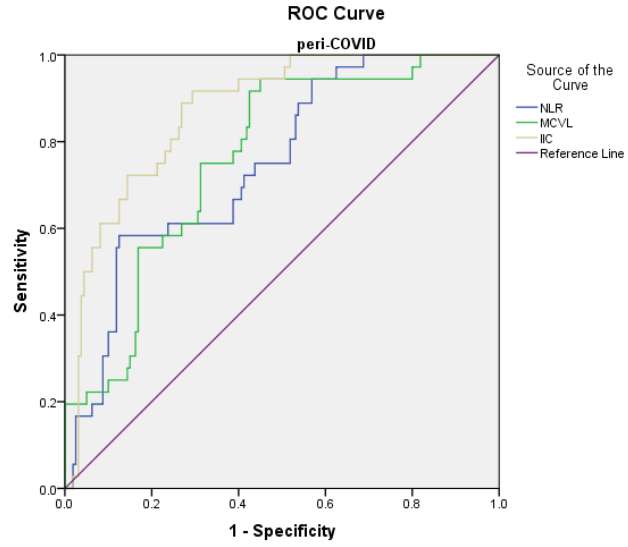
Figure 5. Receiver operating characteristic (ROC) curve for logistic regression models of inflammatory markers related to death in the peri-COVID group. Table 8. Cutoff values of laboratory parameters for determining the risk of death in the pre-COVID (1) and peri-COVID (2)